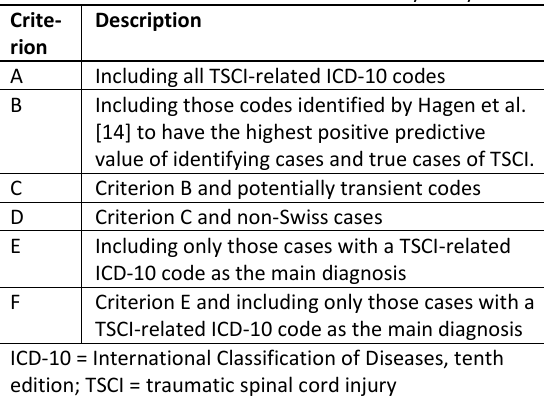
Table 1: Code selection criteria for sensitivity